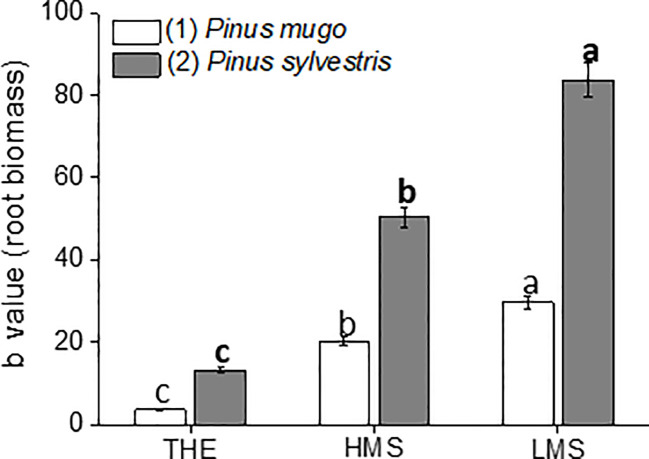
Root dry biomass of garlic plantlets grown in hydroponics and treated for 48 h with total humic extracts (THE) and size-fractionated HS (high molecular size, HMS and low molecular size, LMS) extracted from soil (1) (with Pinus mugo cover) and (2) (with Pinus sylvestris cover). The b values of the regression curve in the range 0–1mg C L−1 are reported. Different letters represent significant differences at p < 0.05 (n = 10). Unbolded letters compare HS from soil (1), letters in bold compare HS from soil (2).